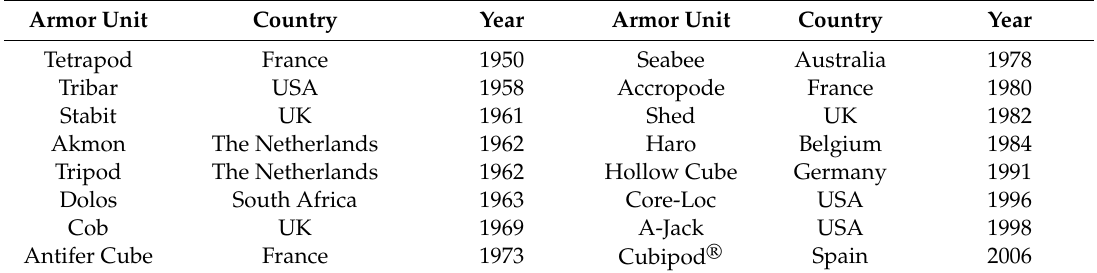
Table A1. Main special shaped armor units. Adapted from The Rock Manual